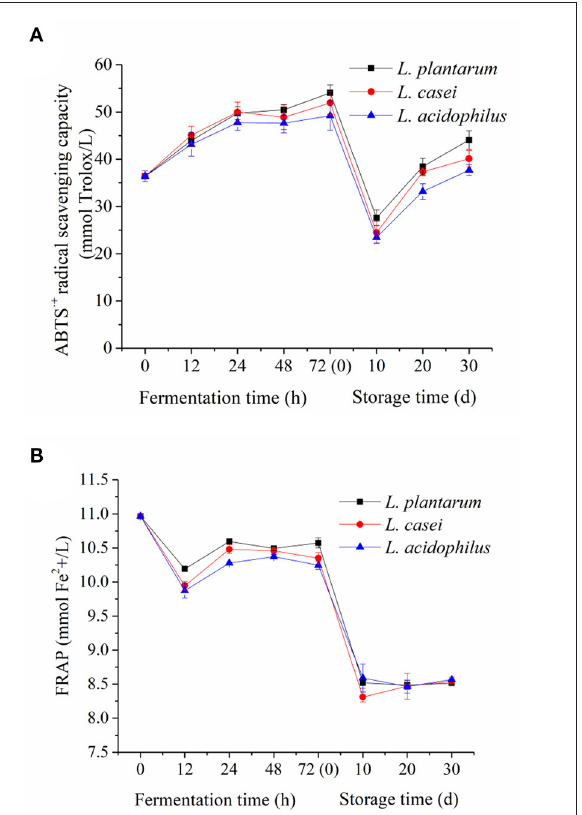
FIGURE 4 | The antioxidant activity of unfermented and LAB-fermented apple juice in vitro . (A) ABTS ·+ radical scavenging activity, (B) ferric reducing antioxidant